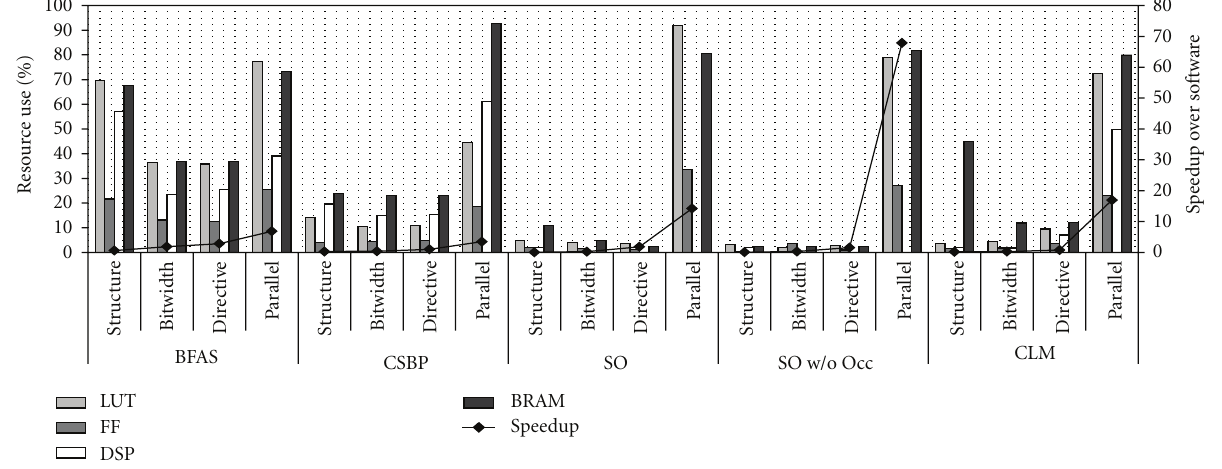
Figure 8: Resource use (left y -axis) and speedup (right y -axis) for each ISE synthesizable software version. Directive denotes the pipelining and loop optimization step.